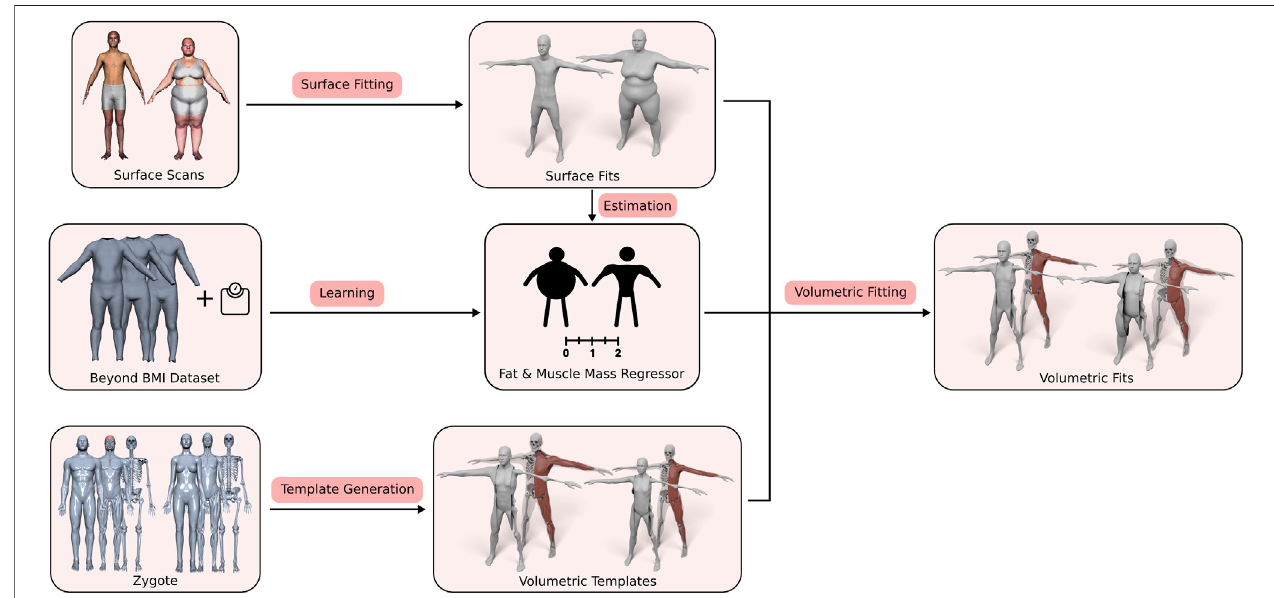
FIGURE 2 | Overview of our volumetric template fi tting approach. From the Zygote model (Zygote, 2020), we build layered volumetric templates for the male and female anatomy. By adapting the BeyondBMI dataset (Maalin et al., 2020) we learn a model for estimating fat and muscle mass from a surface model. Given a person ’ s surface scan, we then estimate its fat/muscle mass and use this information to fi t the volumetric template (in)to the surface scan, which yields the personalized anatomical model.